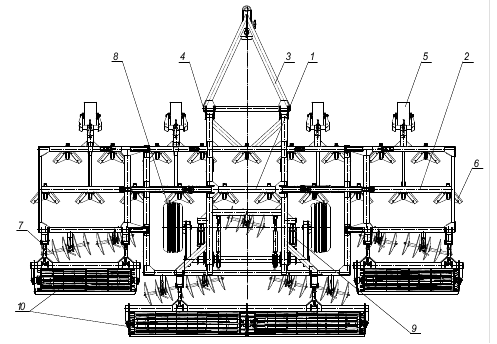
Figure 12. Scheme of the experimental sample of the combined tool for the main tillage (top